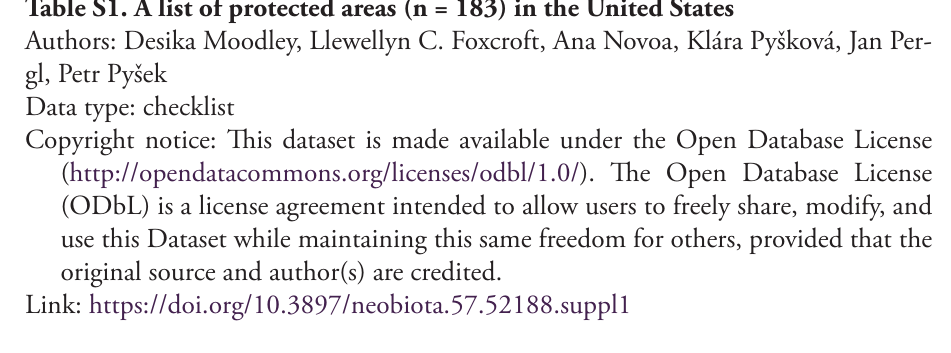
Table S1. A list of protected areas (n = 183) in the United